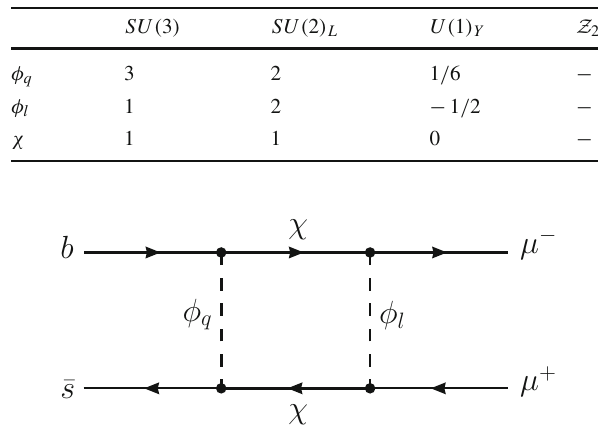
Fig. 1 One-loop diagram contribution from the new particles to the b → s μ + μ − transitions